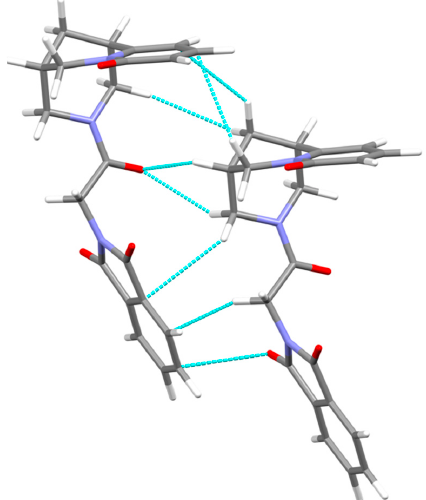
Figure 7. An example of a pair of molecules (related by unit translation along the x-direction) and connected by weak, numerous interactions, giving rise to relatively high interaction energy: Eint: − 51.8 kJ/mol (B3LYP); − 55.3 kJ/mol (PIXEL). Table 4. The details of the interactions for the pair of the highest interaction energy in 1 ( i: –1+x, y, z: 8 contacts with critical points). Upper part: geometrical details; lower: topological; D12: distance between two atoms; Gcp: kinetic energy density (kJ/mol/Bohr3); Vcp: potential energy density (kJ/mol/Bohr 3 ); Dcp1, Dcp2: distance from the first and the second atom to the critical point, re- spectively; Lap: laplacian (cid:4670)(cid:1487) (cid:2870) (cid:3435)ρ (cid:2912)(cid:2913)(cid:2926) (cid:3439) (eÅ -5 )]; Den: electron density (cid:4670)ρ (cid:2912)(cid:2913)(cid:2926) (eÅ − 3 )].